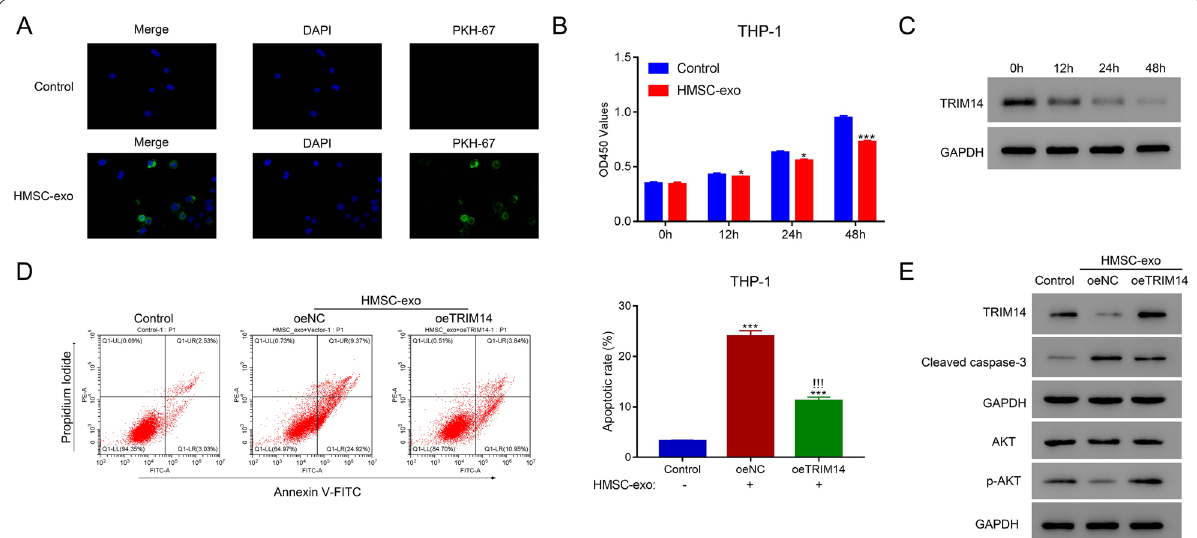
Fig. 3 HMSC-exos suppressed the proliferation of AML cells. A The uptake of HMSC-exos labeled with PKH-67 by human THP-1 cells was detected using immunofluorescence. B The proliferation of THP-1 cells co-cultured with HMSC-exos. C The protein level of TRIM14 in THP-1 cells after co-cultured with HMSC-exos. D Overexpression of TRIM14 suppressed the apoptosis of THP-1 cells after co-cultured with HMSC-exos. E The expression of TRIM14, cleaved caspase-3, AKT and p-AKT in the presence of oeTRIM14 and HMSC-exos. * p < 0.05; *** p < 0.001; !!!*** p < 0.001 vs